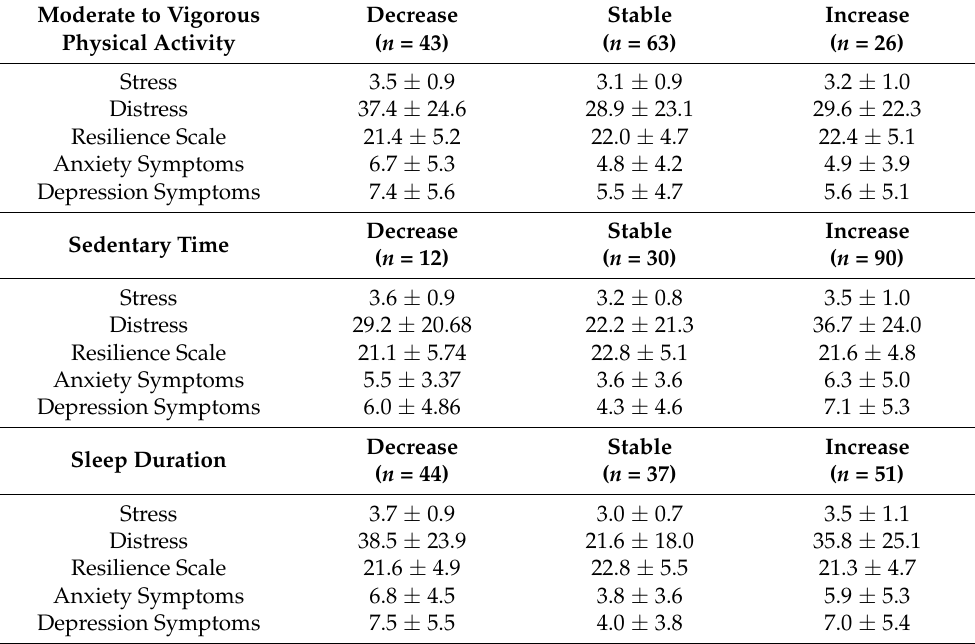
Table 2. Mental health outcomes according to lifestyle behavior change ( n = 132) a